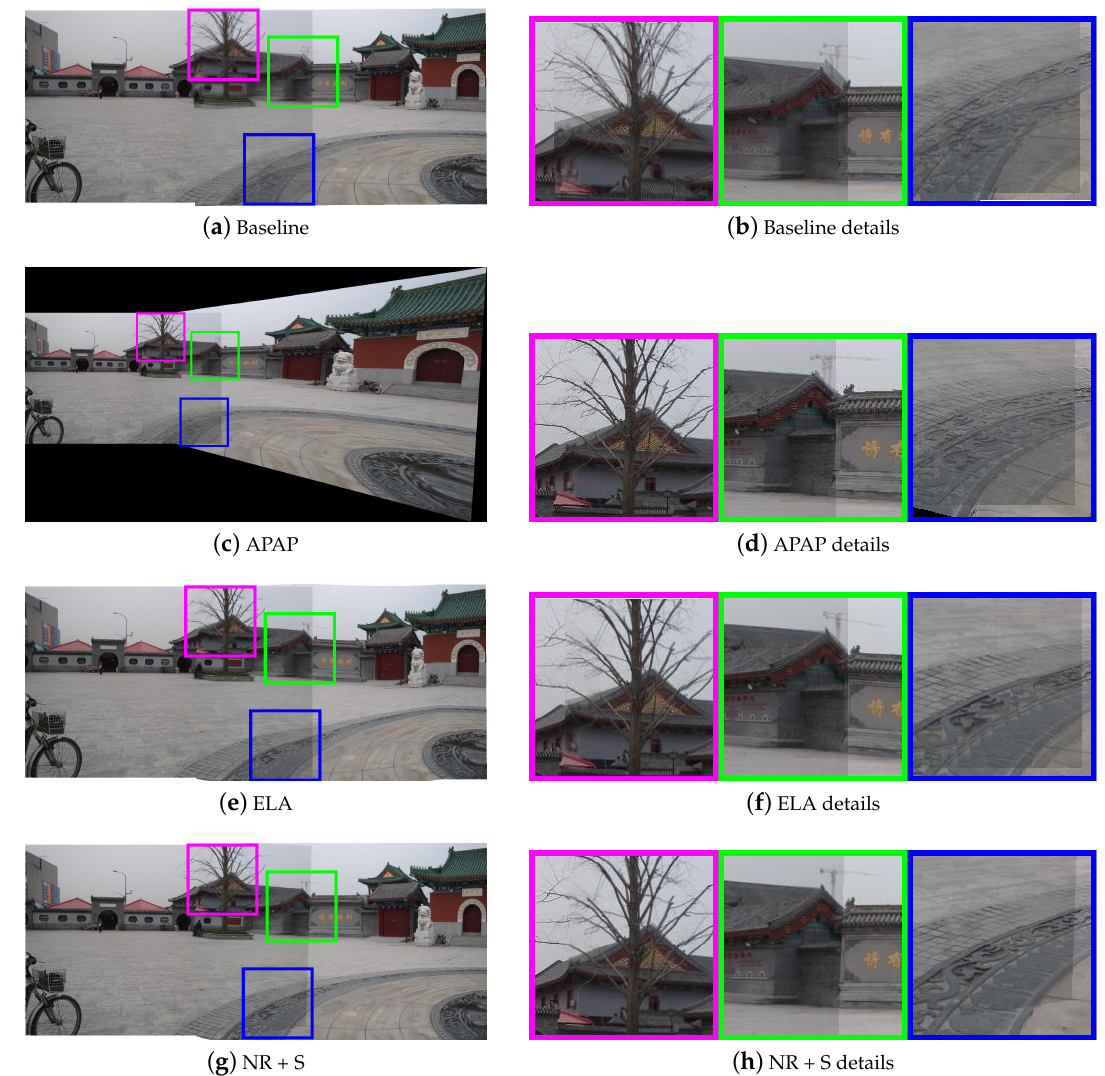
Figure 7. Comparison of stitching quality on “temple”. ( a , b ) are results of the baseline with obvious local misalignments. ( c , d ) are results of as-projective-as-possible (APAP). ( e , f ) are resluts of elastic local alignment (ELA). ( g , h ) are resluts of nonrigid + similarity